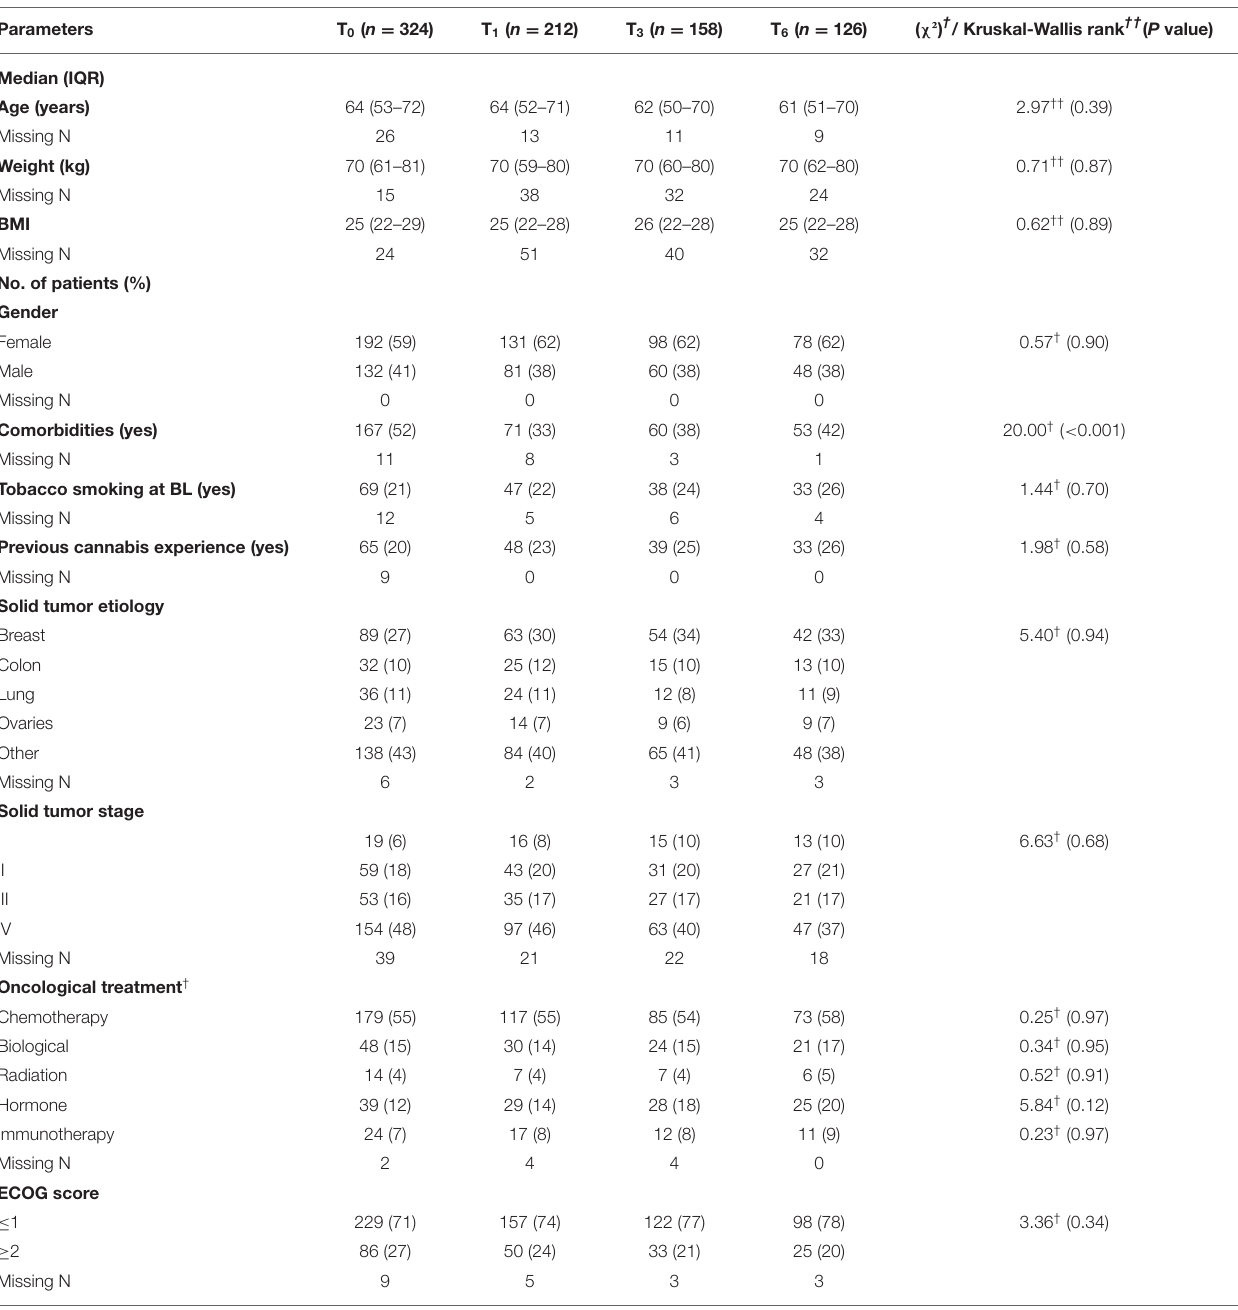
TABLE 1 | Demographic and cancer characteristics of the cohort at all time points.